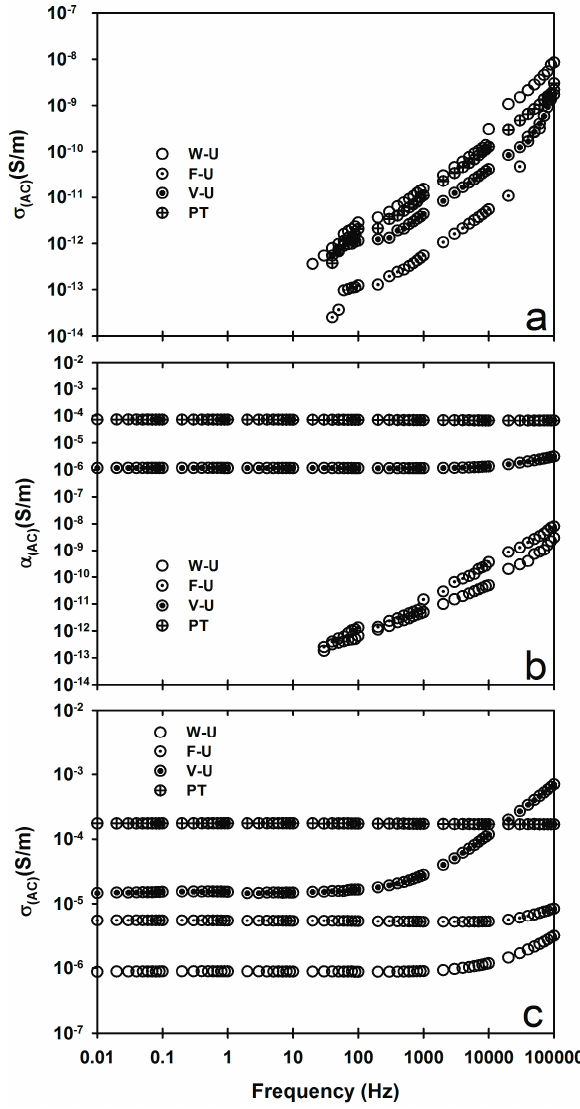
Figure 3. σ (AC) for ( a ) iPP MFI=2.5 /MWCNT; ( b ) iPP MFI=34 /MWCNT; and ( c ) iPP MFI=1200 /MWCNT fabricated using different ultrasound-assisted extrusion methods.